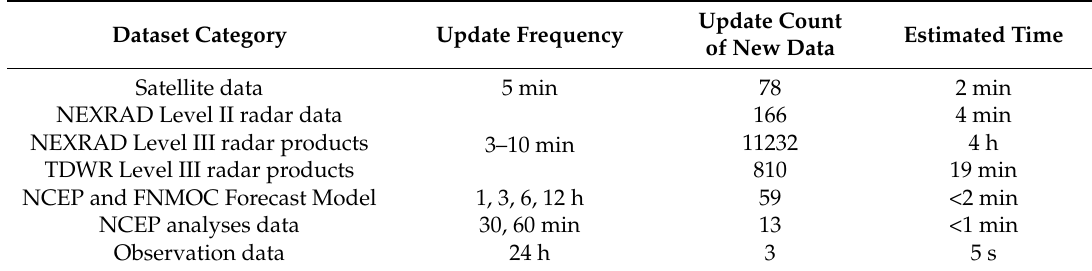
Table 5. Estimated time to register new online metadata each